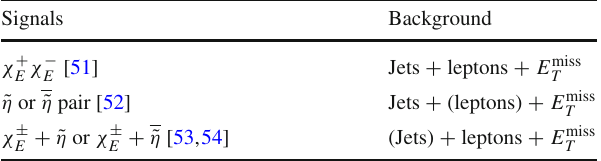
refers to missing transverse T